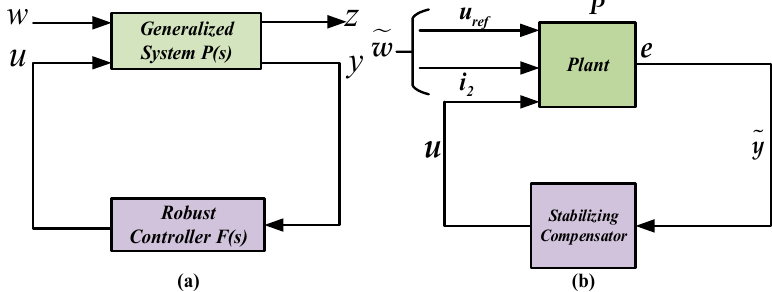
Figure 1. Schematic of the system with the H ∞ robust controller.